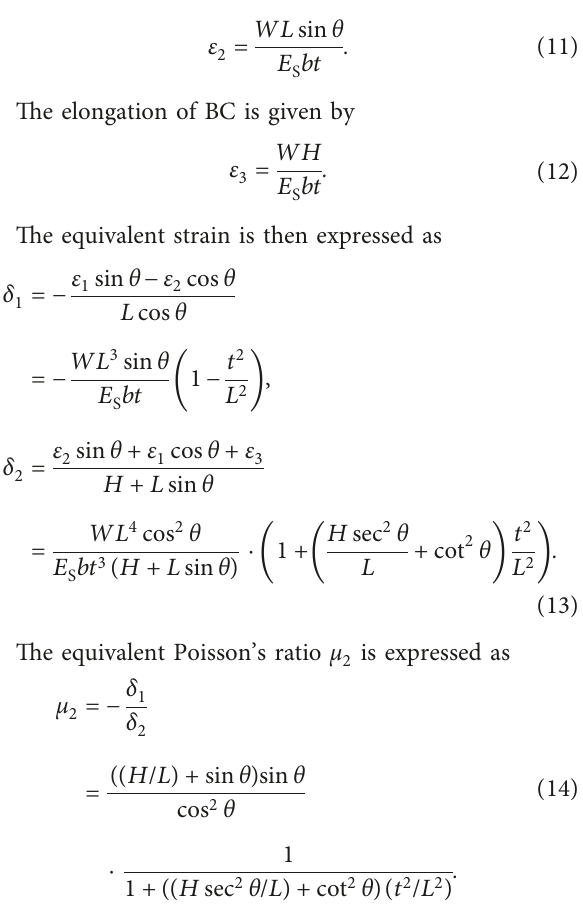
Figure 5: Honeycomb cell.